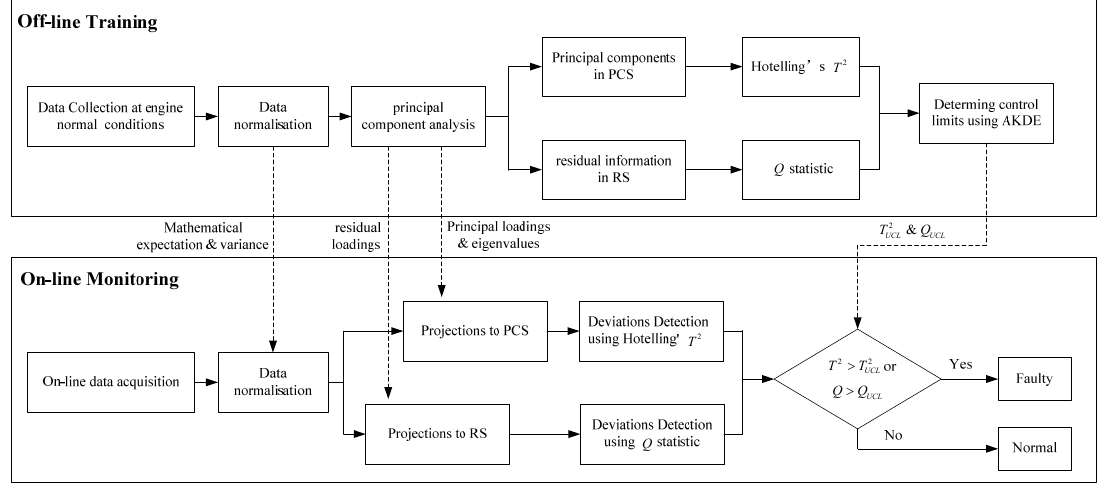
Table 5. The improved performance of engine fault detection rate by using multivariate statistics.